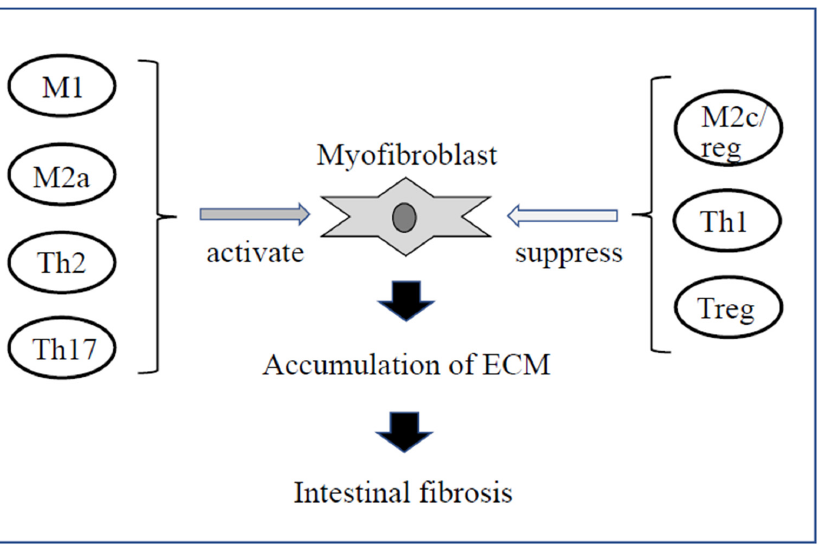
Figure 2. Association between immune response and fibrosis. M1 macrophages activate myofibroblasts and fibrosis. M2a macrophages produce pro-fibrotic factors, while M2c/reg macrophages are